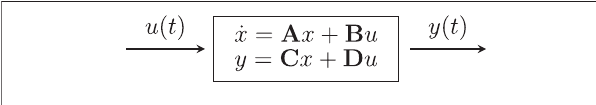
FIGURE 1 | System